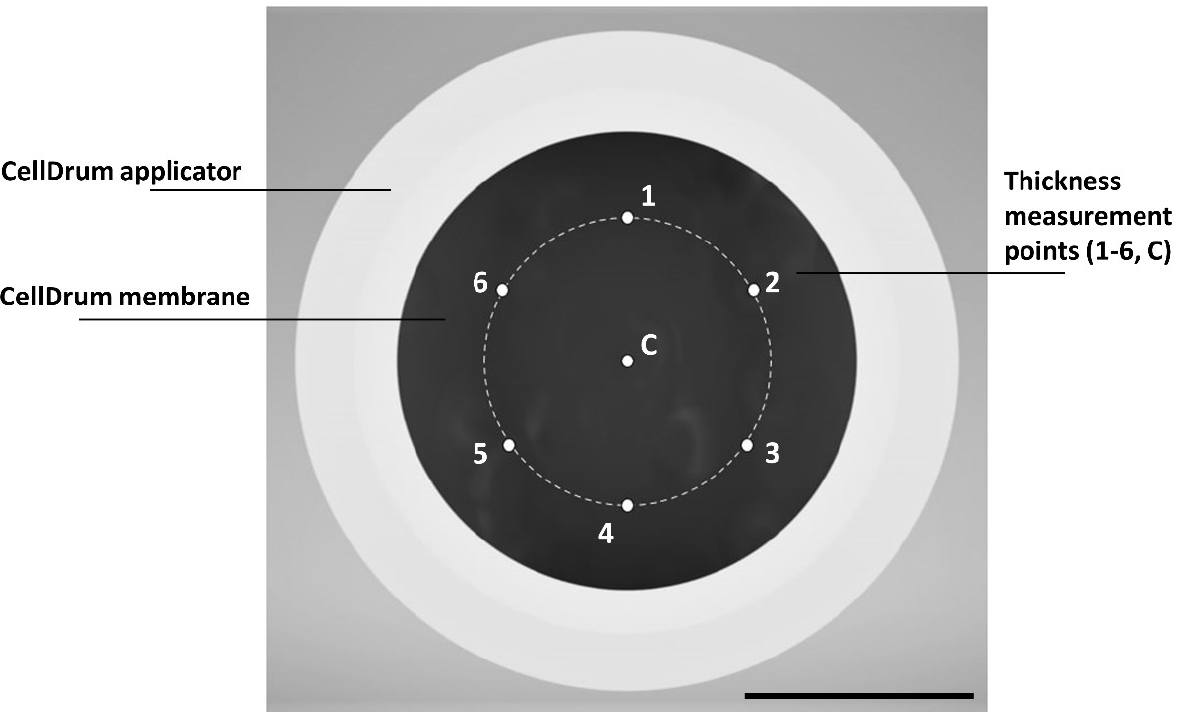
Figure 2 . Positioning of thickness measuring points for CellDrum membranes ( top view). Inner membrane diameter is 1.6 cm, and angular spacing of the data points on the measuring circle is 60°. Measurement points are numbered from 1–6 for eccentric measurements and C for central, respectively. The scale bar represents 8 mm in length.